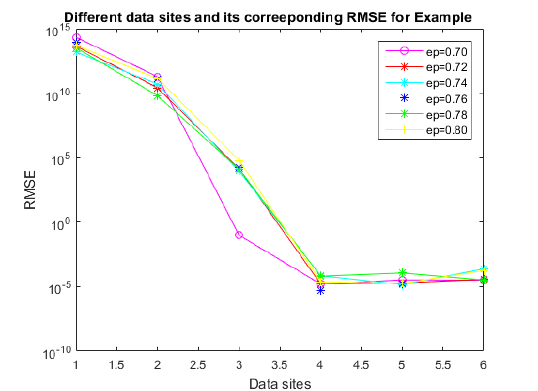
Figure 6. Error Comparison for Example 3